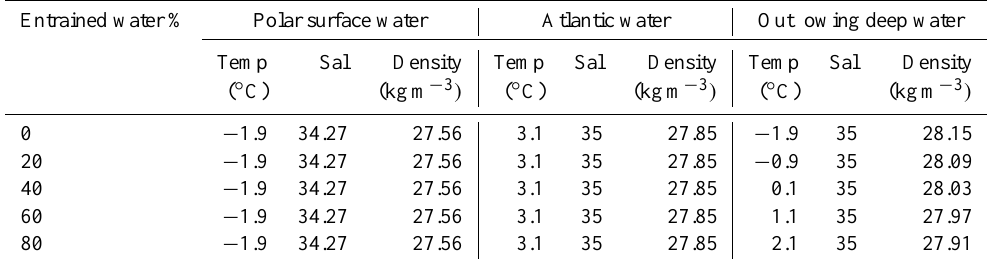
Table 1. Properties of the Atlantic water, the Polar surface water and the deep water for different percentages of entrained ambient (Atlantic) water.